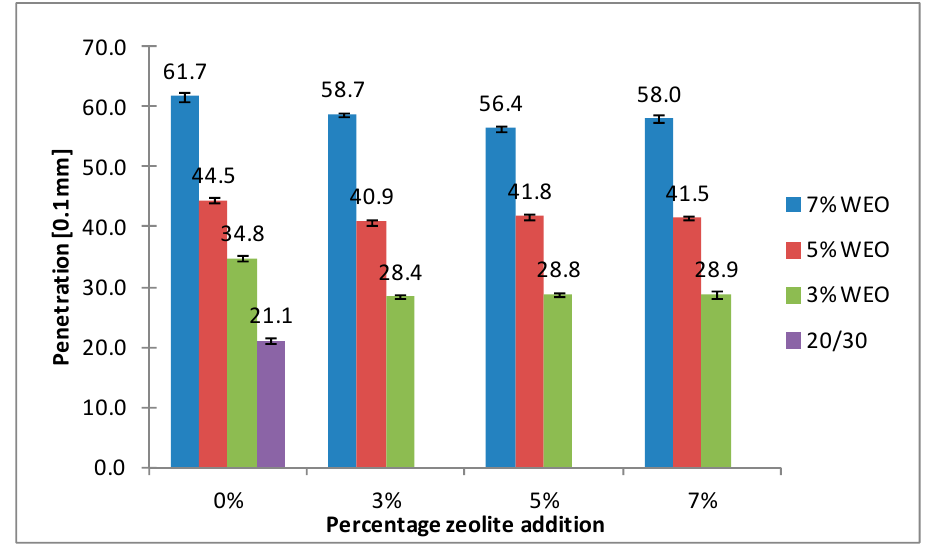
Figure 13. The results of penetration tests for the 20/30 asphalt with the addition of WEO and clinoptilolite zeolite measured at 25 °C.